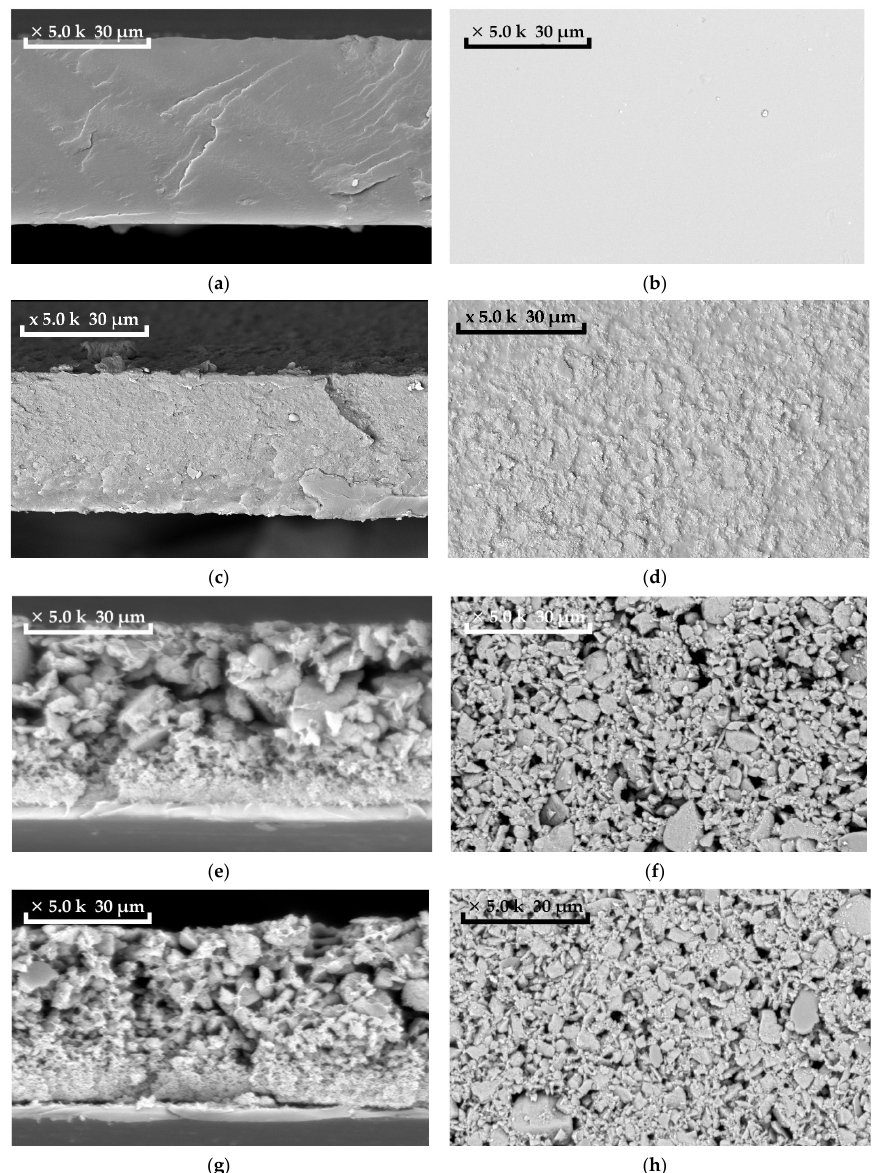
Figure 3. SEM images of membranes: ( a ) cross-section of PTMSP membrane, magnification 5000×; ( b ) top view of PTMSP membrane, magnification 5000×; ( c ) cross-section of membrane with 10 wt% HCPS content in PTMSP, magnification 5000×; ( d ) top view of the membrane with 10 wt% HCPS content in PTMSP, magnification 5000×; ( e ) cross-section of the membrane with 30 wt% HCPS con- tent in PTMSP, magnification 5000×; ( f ) top view of the membrane with 30 wt% HCPS content in PTMSP, magnification 5000×; ( g ) cross-section of the membrane with 50 wt% HCPS content in